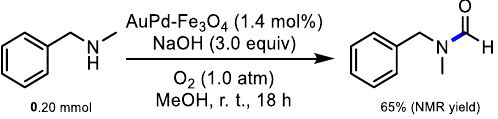
Table 1. Screening data of the N -formylation of amine 1